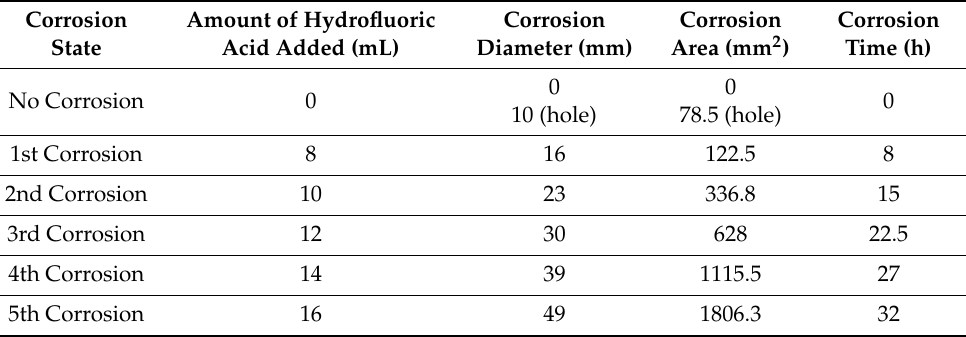
Table 5. Corrosion state and specific volume and time.